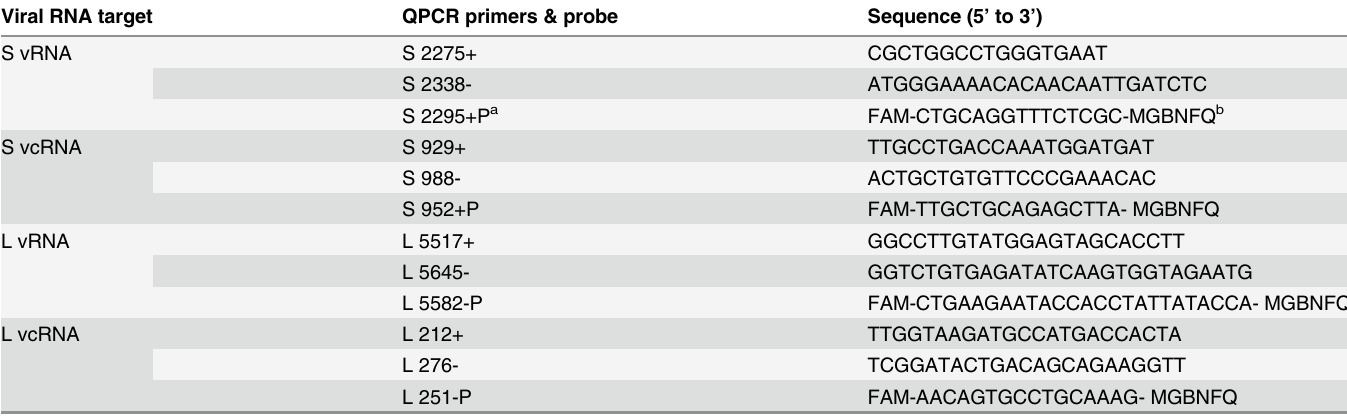
Table 3. Primers and probe sets for